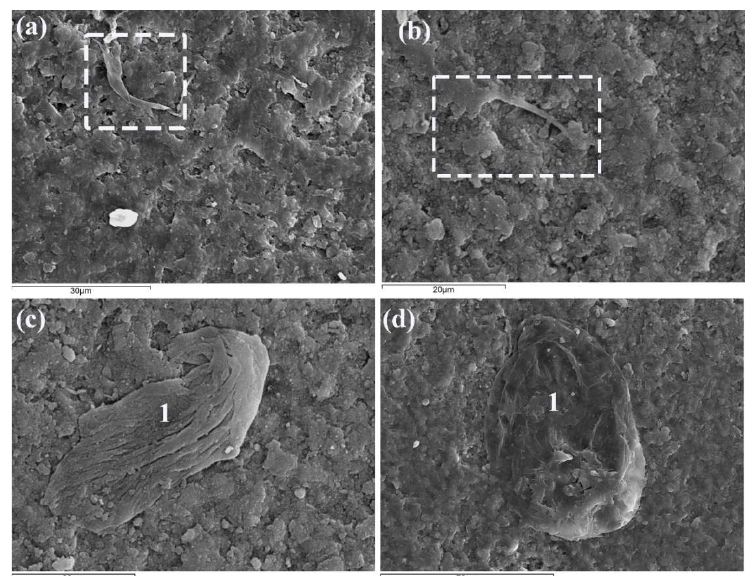
Figure 11. ( a , b ) Secondary electron image (SEI) in sample MB1a showing silicified bioclast remnants within the dottet boxes; ( c , d ) 1: siliceous bioclast fragments.